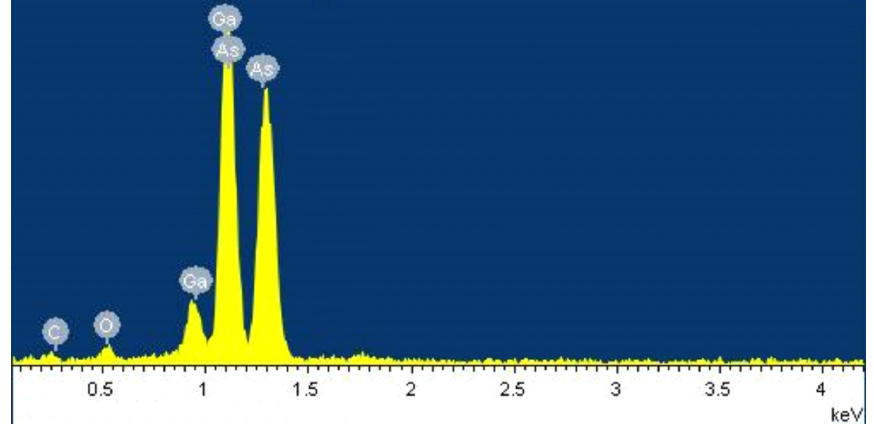
Figure 4. Typical EDX spectrum of GaAs NW measured at the center of the NW.